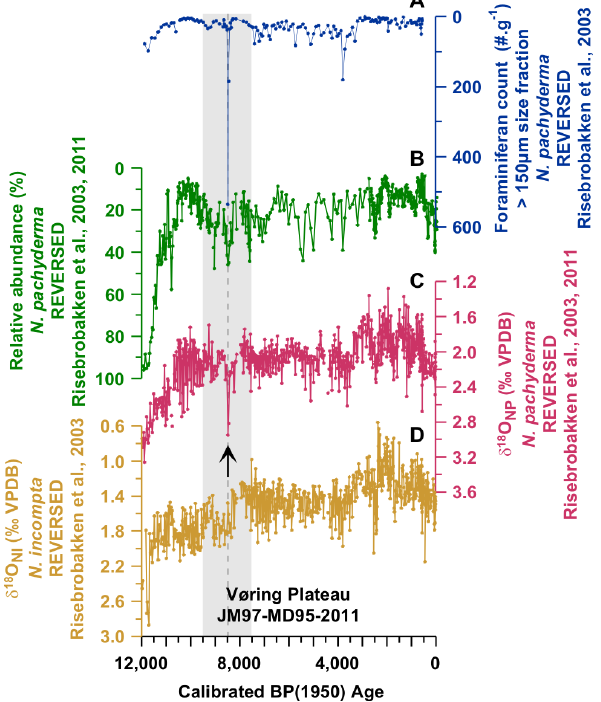
Figure 4. The unique (sub)surface-ocean cold event at the mid- Norwegian Margin. (a) N. pachyderma count in the >150µm size fraction (Risebrobakken et al., 2003a, b). (b) Relative abundance of N. pachyderma in the >150µm size fraction (Risebrobakken et al., 2003a, b). Oxygen-isotope ratios from (c) N. pachyderma (Rise- brobakken et al., 2003d, e) and (d) N. incompta (Risebrobakken et al., 2003d, e). The arrow and the dashed vertical line highlight the prominent maximum in the δ 18 O NP record, while the light-grey shading indicates the interval which is the focus of the paper.